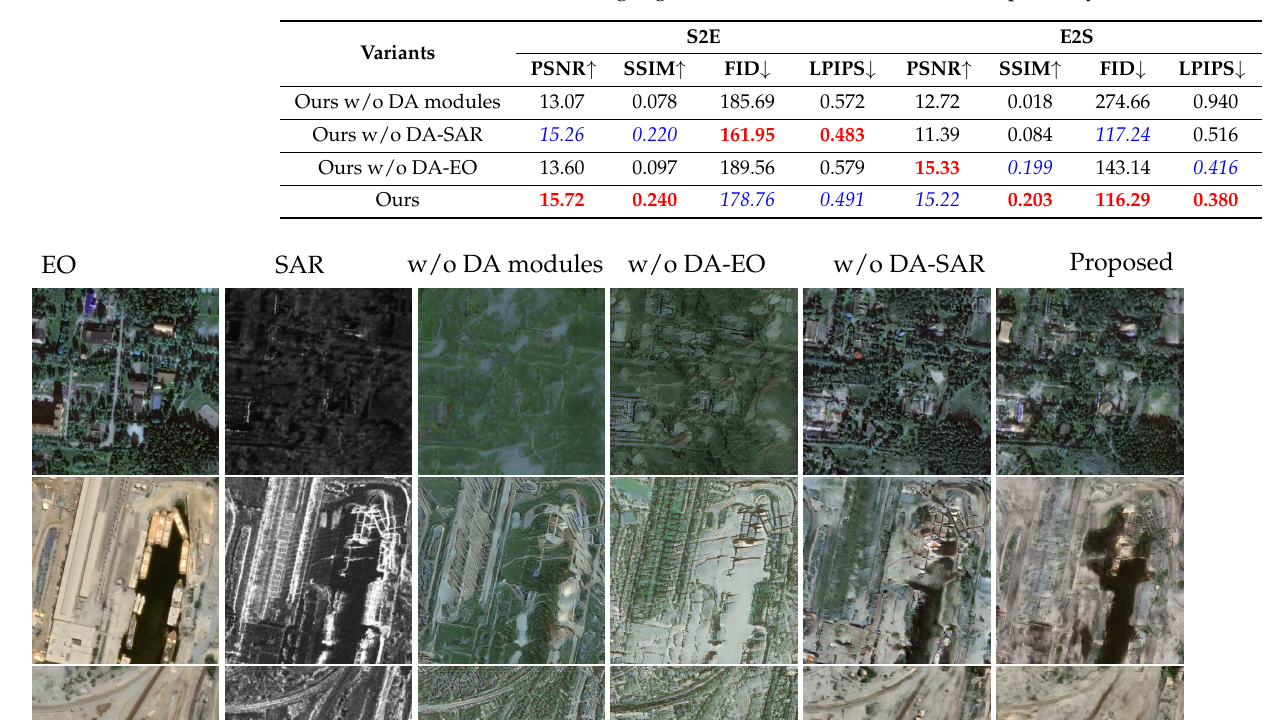
Table 7. Ablation study on SAR2Opt: IQA scores of our proposed method and its three variants. The best and second best results are highlighted as red bold and blue italic , respectively.